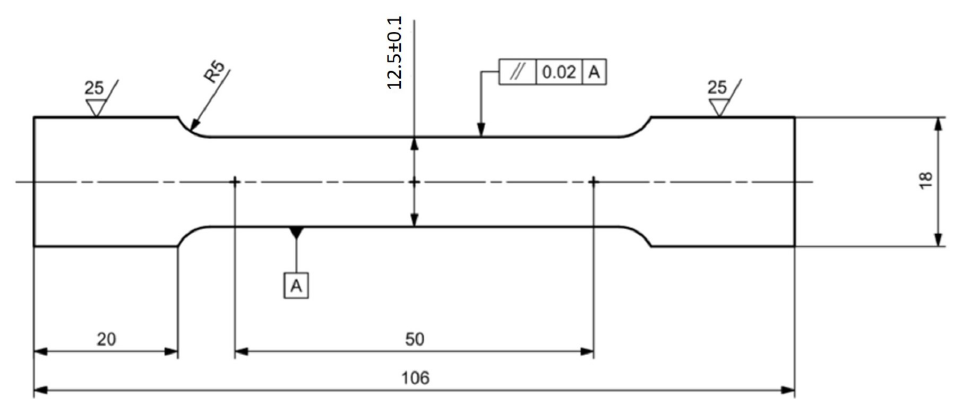
Figure 5. Proposed specimen for static tensile test, all dimensions are in